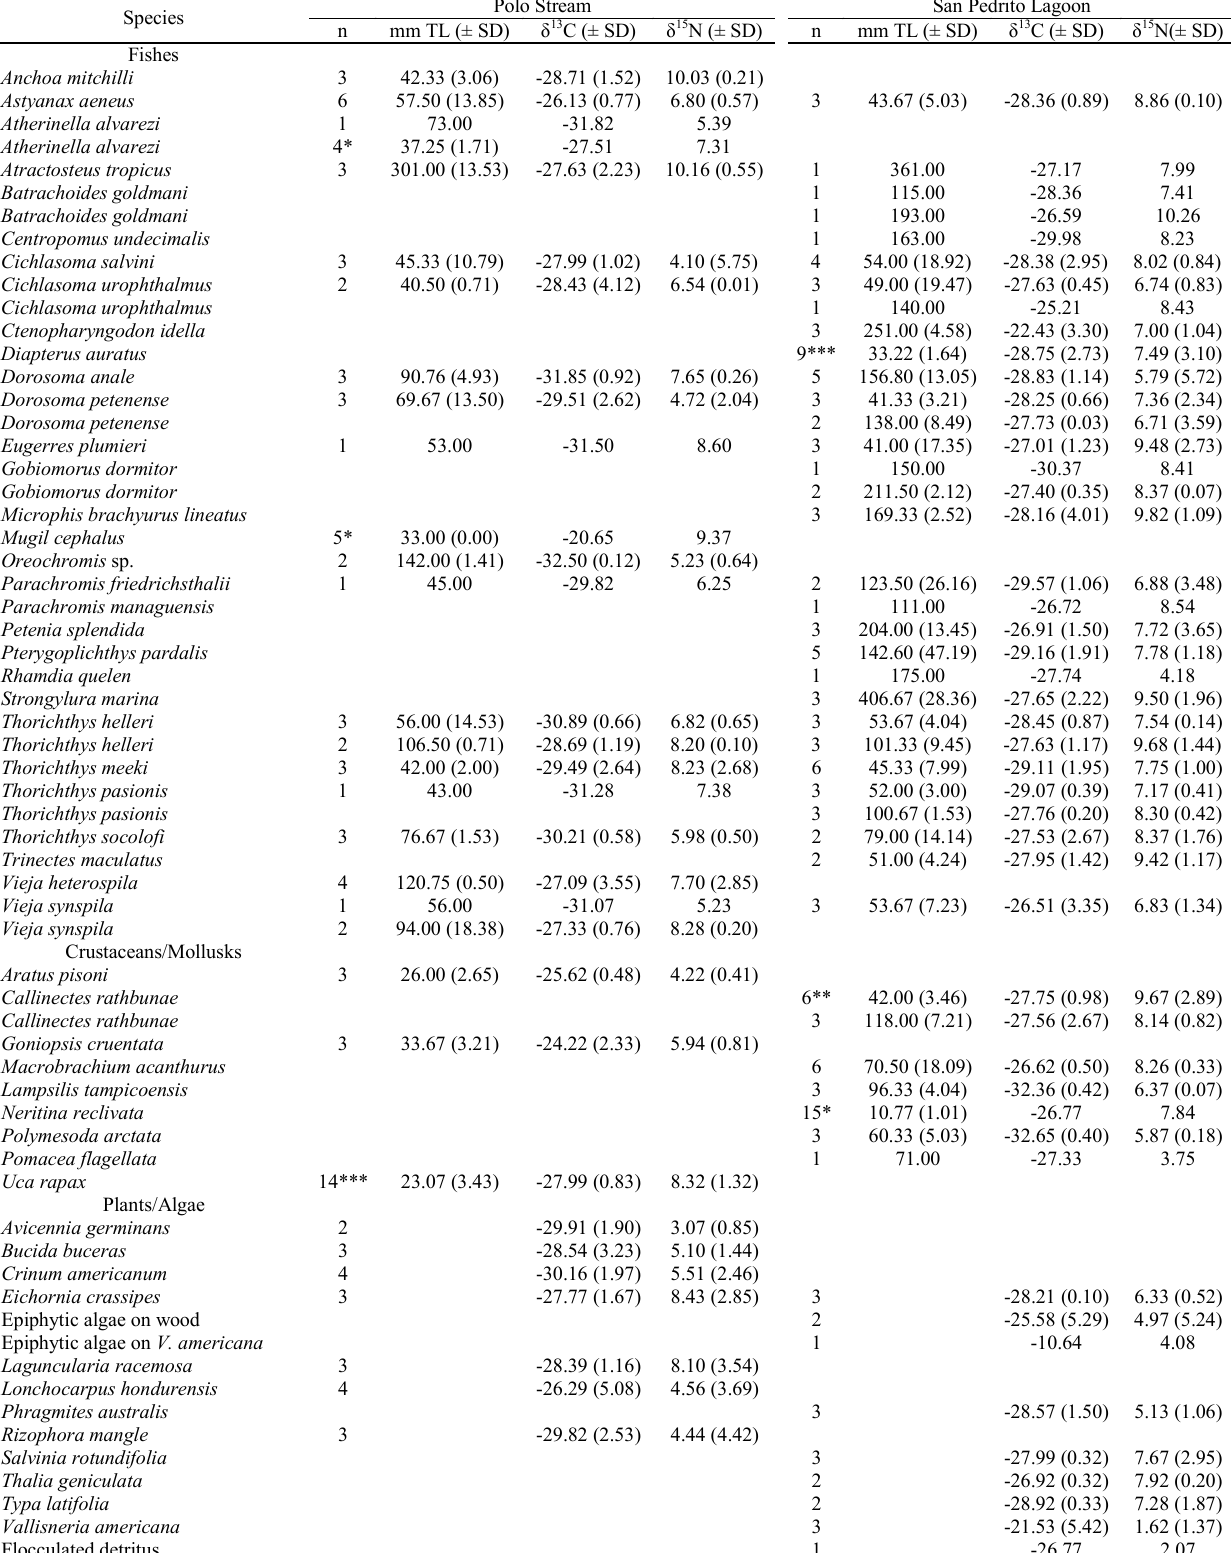
Table 1. Sample size (n) and mean δ 13 C and δ 15 N values (± SD) of primary producers and secondary consumers collected at Polo Stream and San Pedrito Lagoon. Mean total length (mm TL ± SD) is provided for fishes, crustaceans and mollusks. Asterisks (*) designate composite samples (see Methods), and the number of asterisks indicates the number of composite